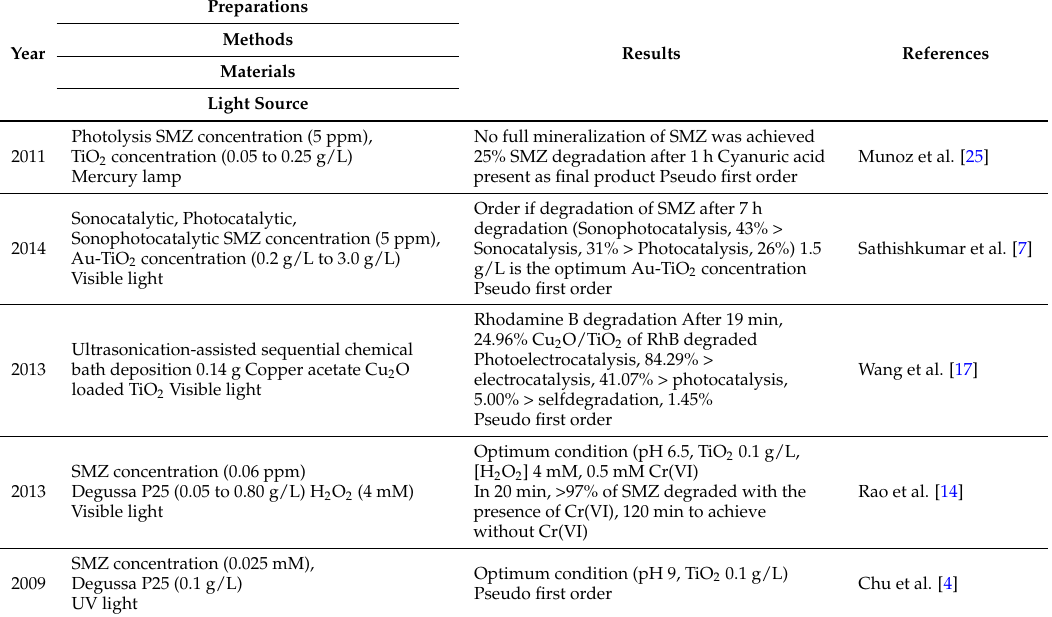
Table 1. The percentage of Simazine (SMZ) degradation obtained by TiO 2